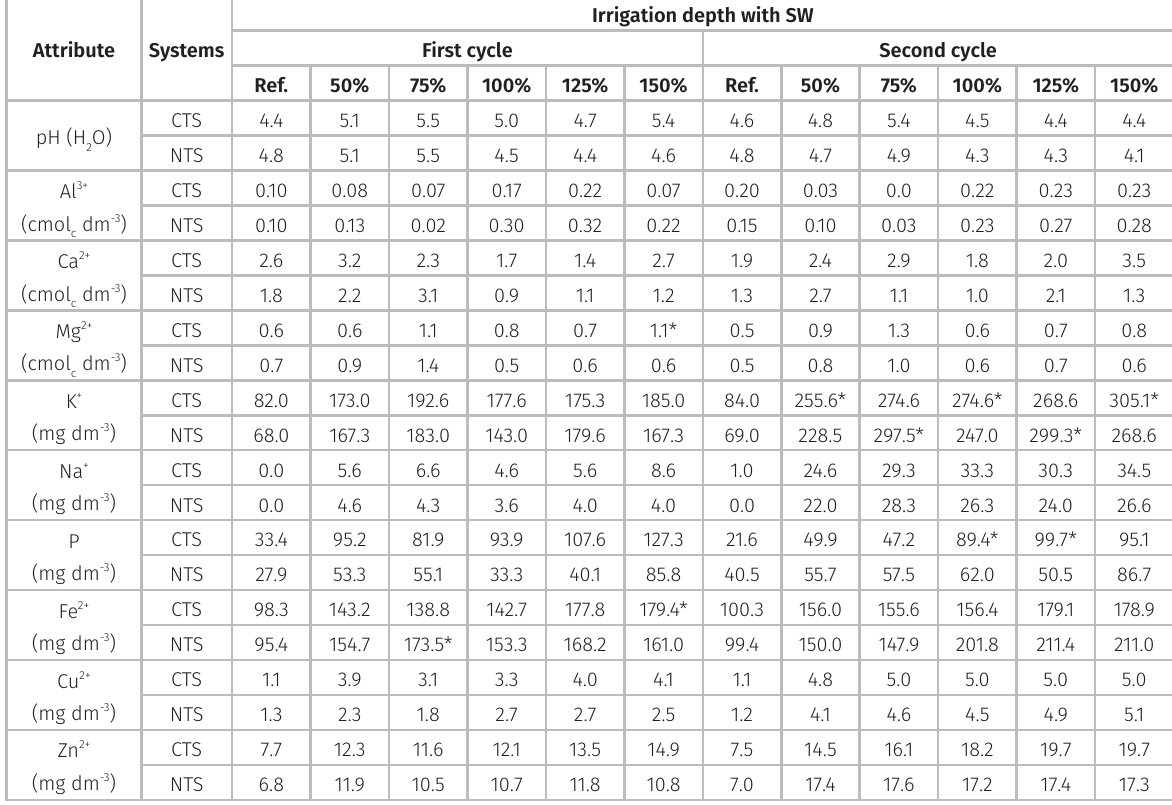
*Indicates significantly different averages between soil management systems at 5% probability by the F test; Ref.: reference plot irrigated with 100% of ETc with water, used only as a